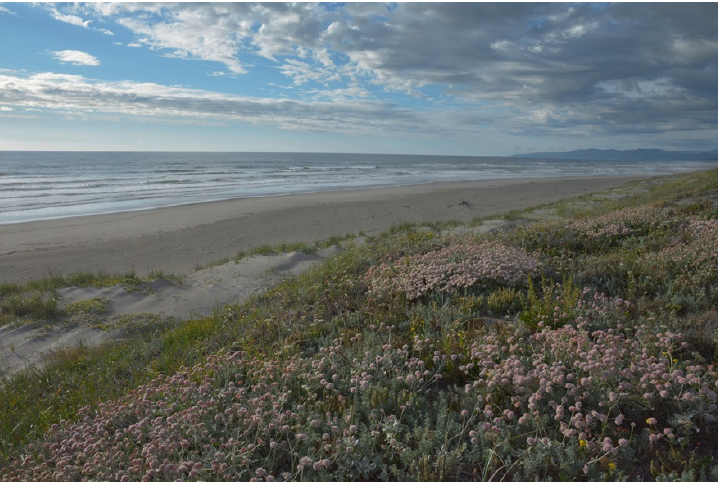
Figure 1. Broad foredune with Elymus mollis dominant. Figure 2. Dune mat community on